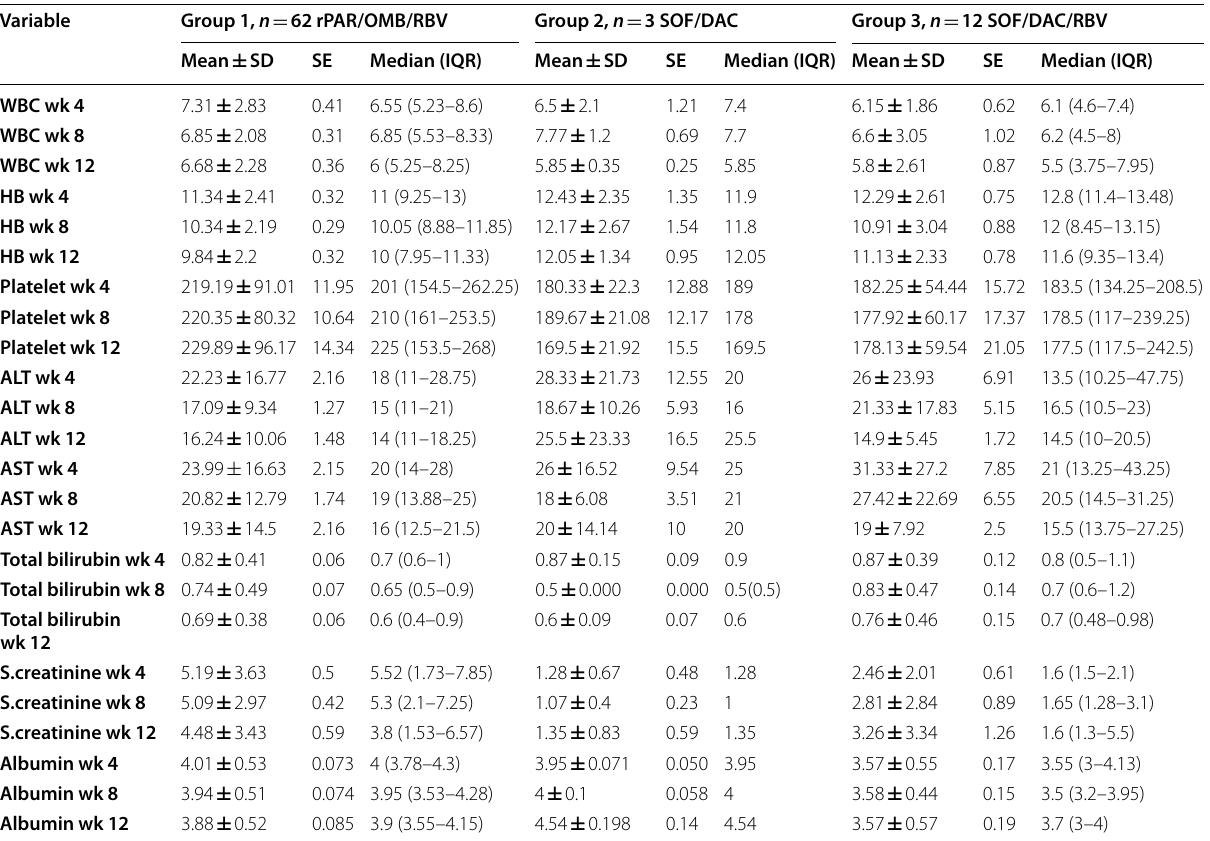
AST aspartate aminotransferase, ALT Alanine aminotransferase, WBC leucocytic count, Hb Hemoglobin